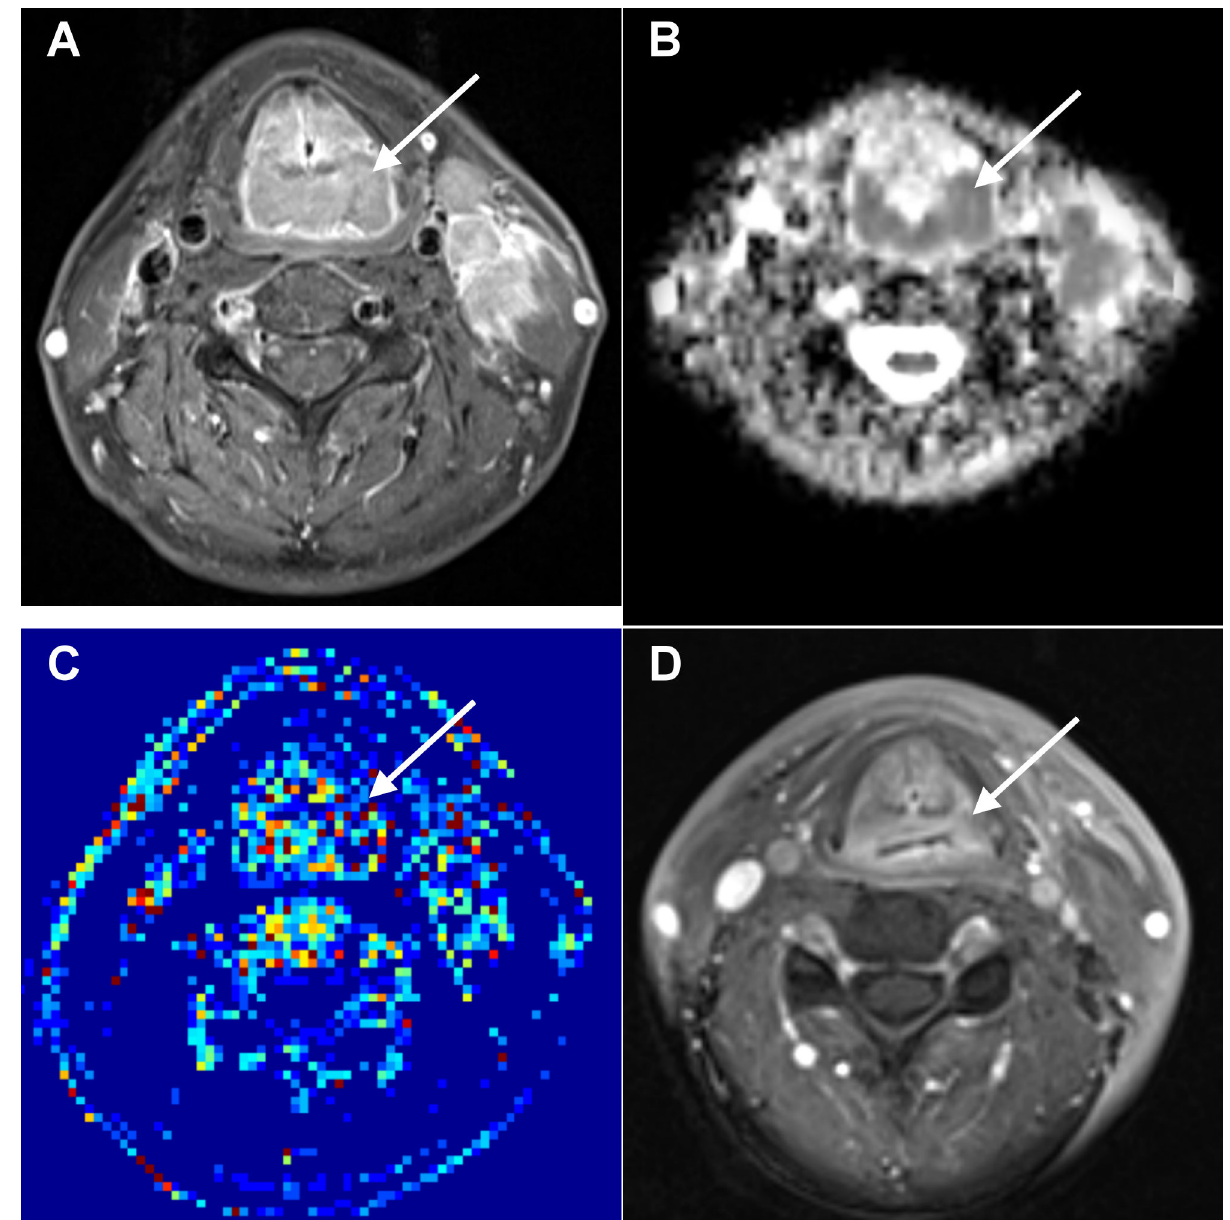
Figure 3. Local failure in a 61-year-old man with oropharyngeal SCC after chemoradiation. A. A pretreatment axial-enhanced MRI shows the oropharynx tumor (arrow). B. The corresponding PWI map shows the tumor with a K trans value of 0.336 min -1 . C. The corresponding ADC map shows the tumor with an ADC value of 0.76 × 10 -3 mm 2 /s. D. Post-treatment axial-enhanced MRI shows a residual left oropharynx tumor (arrow) which was proven by endoscopic